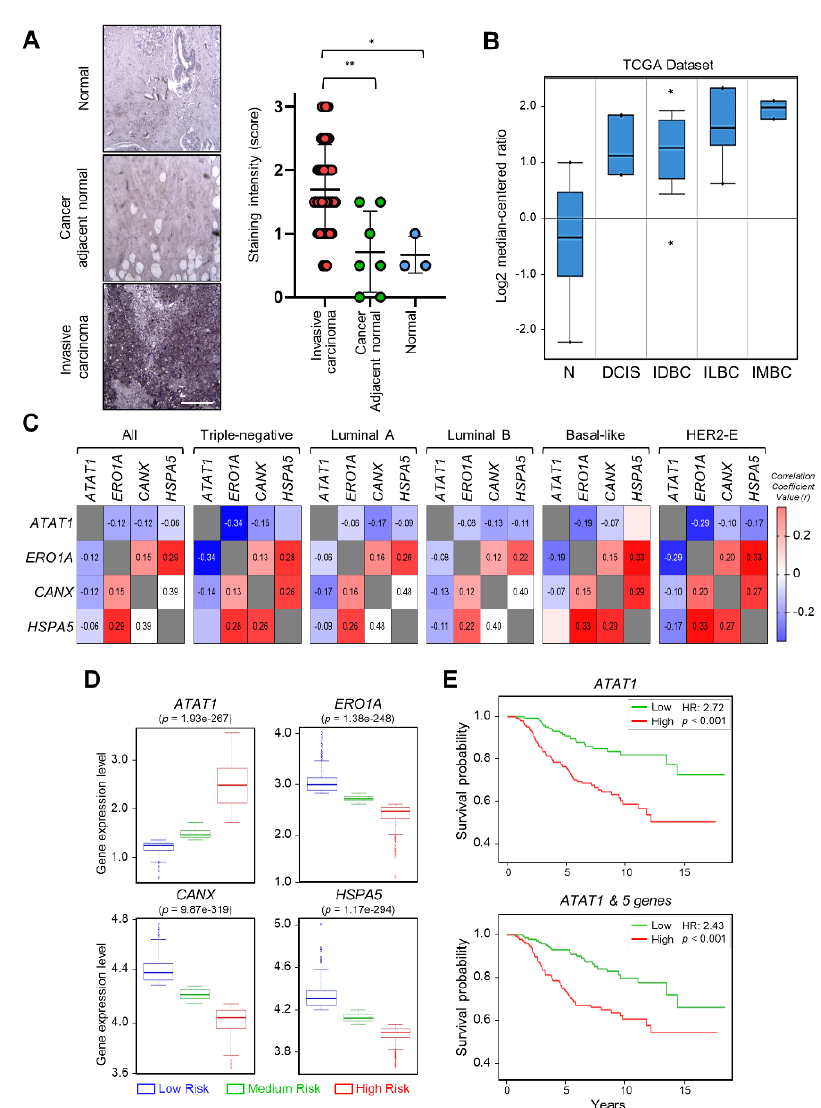
Figure 5. Expression levels of ATAT1 and ER stress marker genes are negatively correlated in breast cancer patients. ( A ) Representative images of immunohistochemistry of acetylated α -tubulin in normal, cancer-adjacent normal, and invasive carcinoma breast tissues. Scale bar, 200 µ m. Lower panels, sample distribution by acetylated α -tubulin staining intensity. Staining intensity was marked (0 = absence, 1 = weak, 2 = moderate, 3 = strong). Values represent the mean ± SD of three independent experiments. Statistical significance was analyzed using one-way ANOVA followed by Tukey’s multiple comparison tests (* p < 0.05, ** p < 0.01). One-way ANOVA (F 2, 47 = 8.552, p < 0.001). ( B ) Analysis of ATAT1 expression levels in normal breast, ductal breast carcinoma in situ, invasive ductal breast carcinoma, invasive lobular breast carcinoma, and invasive mixed breast carcinoma tissues using the Oncomine database. N, normal breast; DCIS, Ductal breast carcinoma in situ; IDBC, invasive ductal breast carcinoma; ILBC, invasive lobular breast carcinoma; IMBC, invasive mixed breast carcinoma. ( C ) Pearson’s correlations between mRNA levels of ATAT1 and ER stress marker genes in breast cancer patients based on the bc-GenExMiner RNA-seq dataset ( n = 4712). Number in the box indicates correlation coefficient value. ( D ) Expression levels of ATAT1 and ER stress marker genes in low-, medium-, and high-risk groups in 962 breast cancer patients from a TCGA dataset. ( E ) Kaplan–Meier plots of breast cancer patients based on the expression of ATAT1 and MAPK8, RASSF1, BCL2, CXCL8, and FGF1 in SurvExpress data ( n = 295). HR, hazard